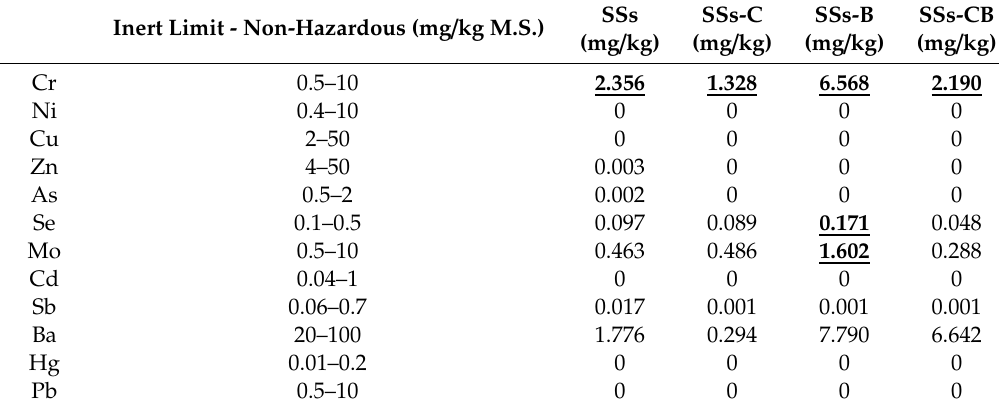
Table 2. Concentrations of metals on leachate at L / S = 10 L / kg and classification according to concentration on heavy